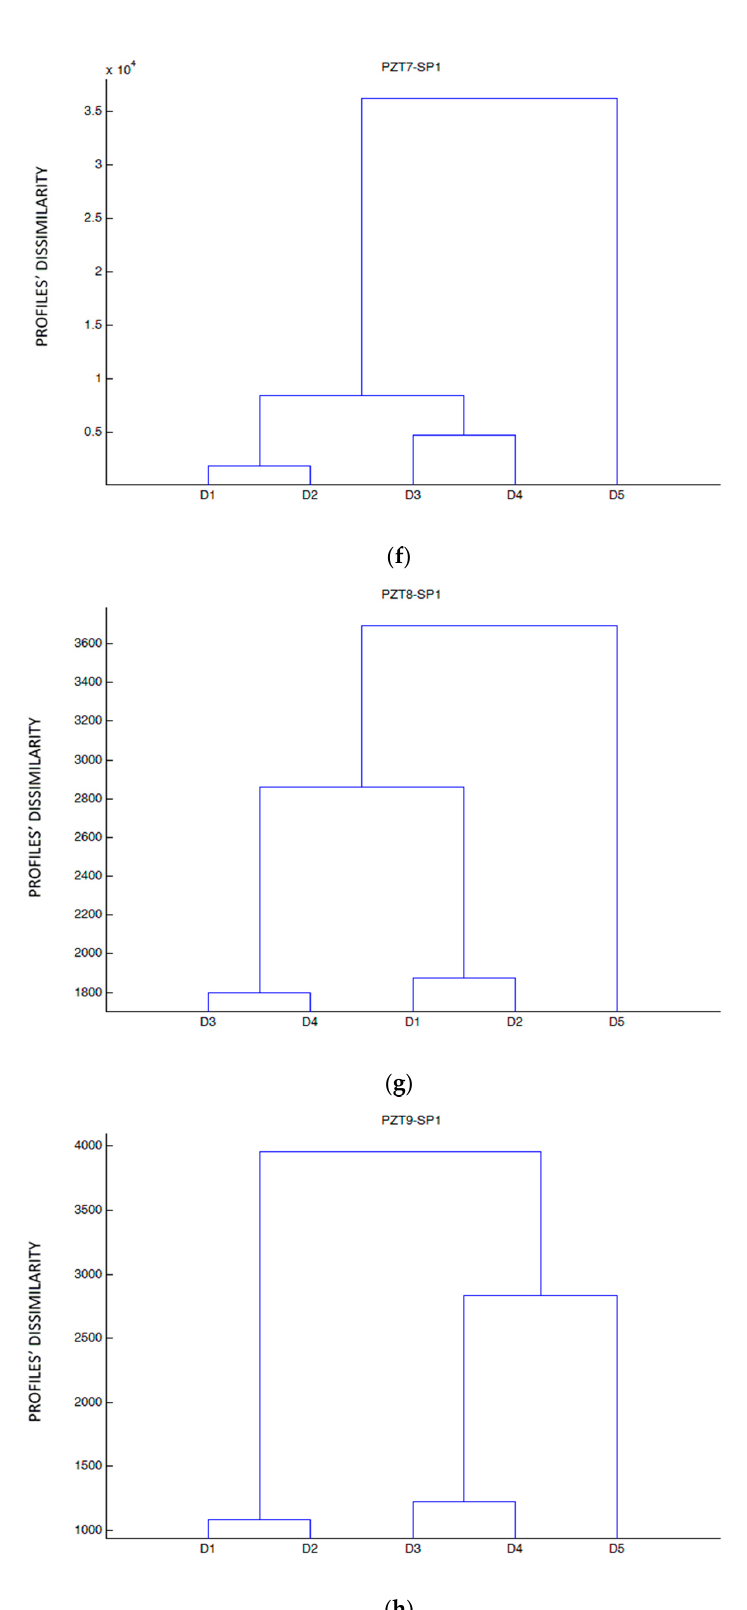
Figure 12. Hierarchical trees for specimen B. ( a ) Sensor PZT1, ( b ) Sensor PZT2, ( c ) Sensor PZT3, ( d ) Sensor PZT4, ( e ) Sensor PZT6, ( f ) Sensor PZT7, ( g ) Sensor PZT8, ( h ) Sensor PZT9.